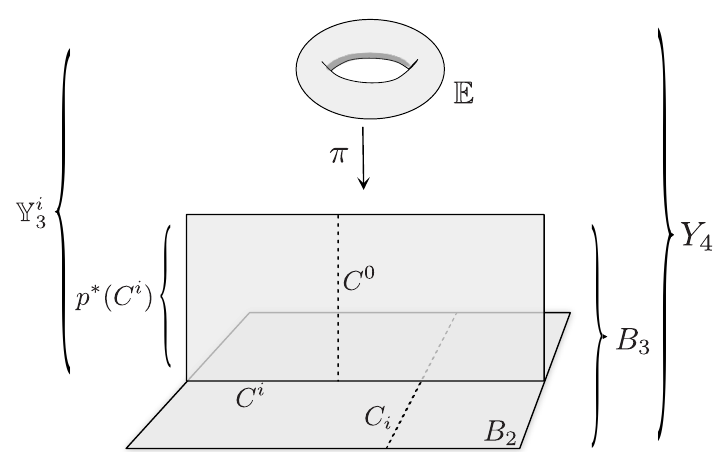
Figure 2 . The derivative contribution to the elliptic genus of a four-dimensional string is captured, in suitable situations, by the relative BPS invariants of certain threefolds Y i fourfold Y 4 . Here we present a sketch of how these threefolds are embedded for the example of a heterotic string. The heterotic string arises in this F-theory geometry from a D3-brane that wraps the rational fiber C 0 in the base threefold, B 3 ⊂ Y 4 . The extra two-form fields B i that are needed for reinstating Green-Schwarz anomaly cancellation arise by expanding the ten-dimensional four-form, C 4 , with respect to the divisor classes p ∗ ( C i ) for i = 1 , . . . h 1 , 1 ( B 2 )